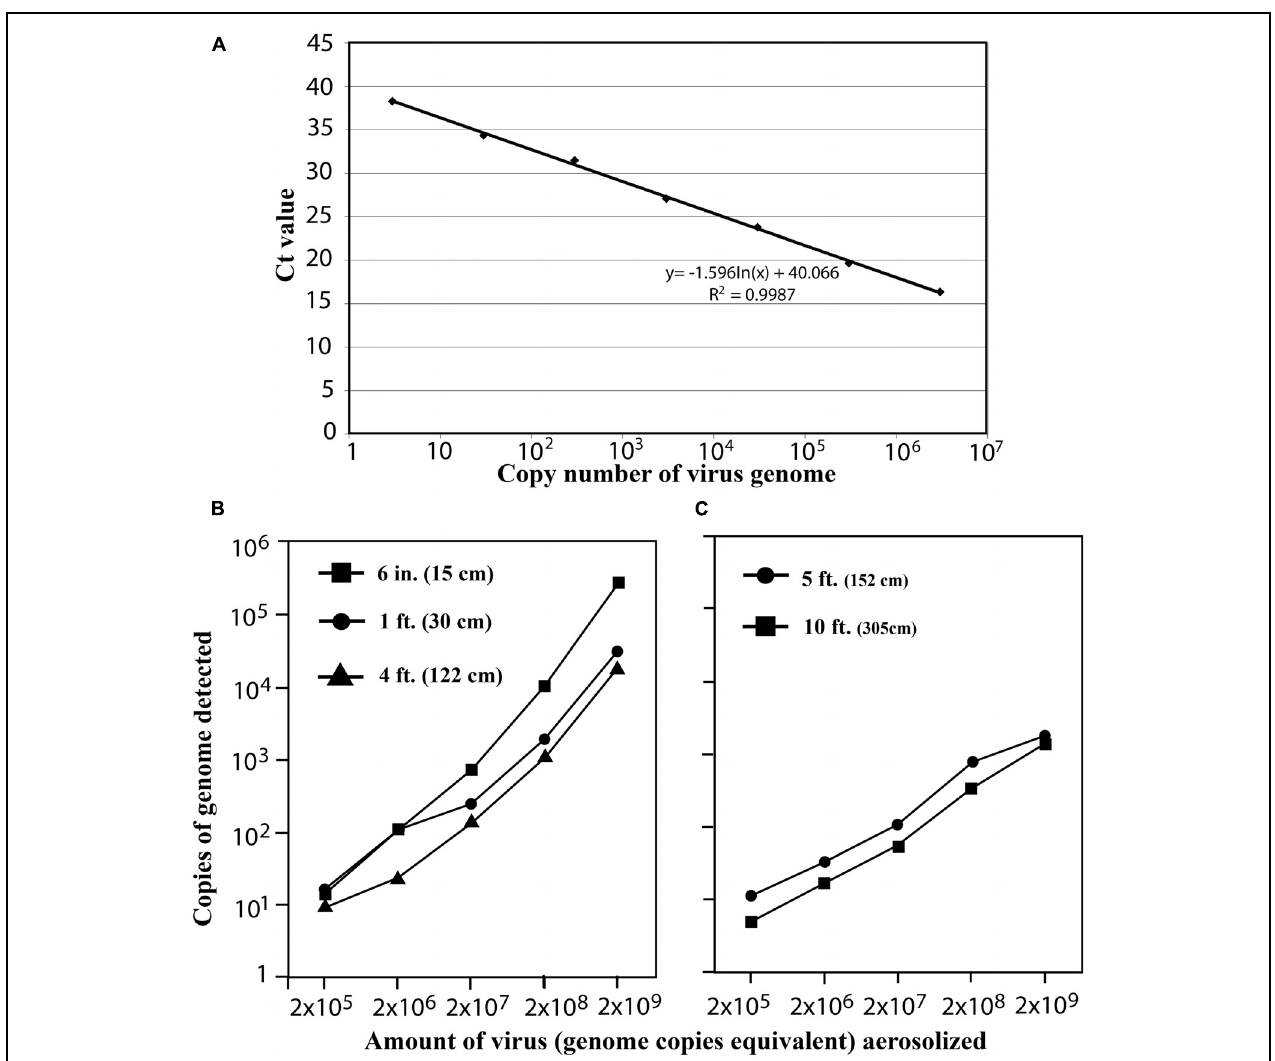
FIGURE 2 | (A) Standard curve for absolute quantification of BAd- (cid:2) E1E3 genome. Tenfold serial dilutions of BAd (cid:2) E1E3 genomes were subjected to Taqman qPCR, and the Ct values were plotted against the absolute numbers of viral genome. (B,C) Detection efficiency of aerosolized BAd- (cid:2) E1E3 virus by ASAP System at different distances. Different concentrations of BAd- (cid:2) E1E3